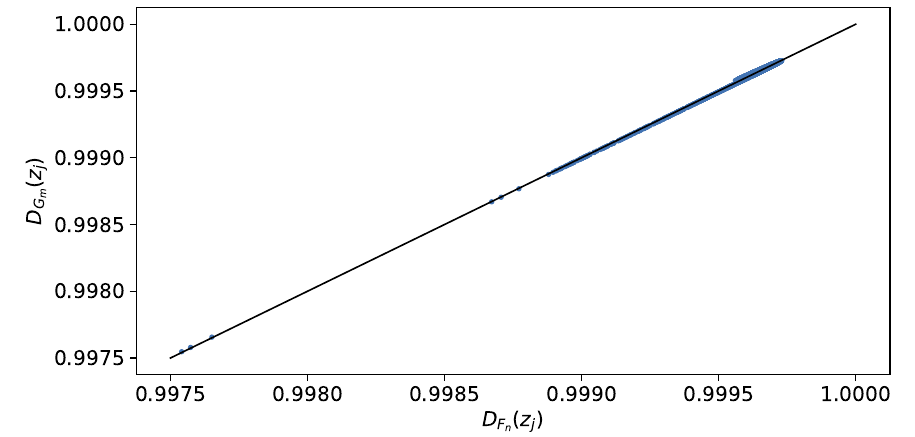
Figure 6. DD-plot of synthetic data vs. real